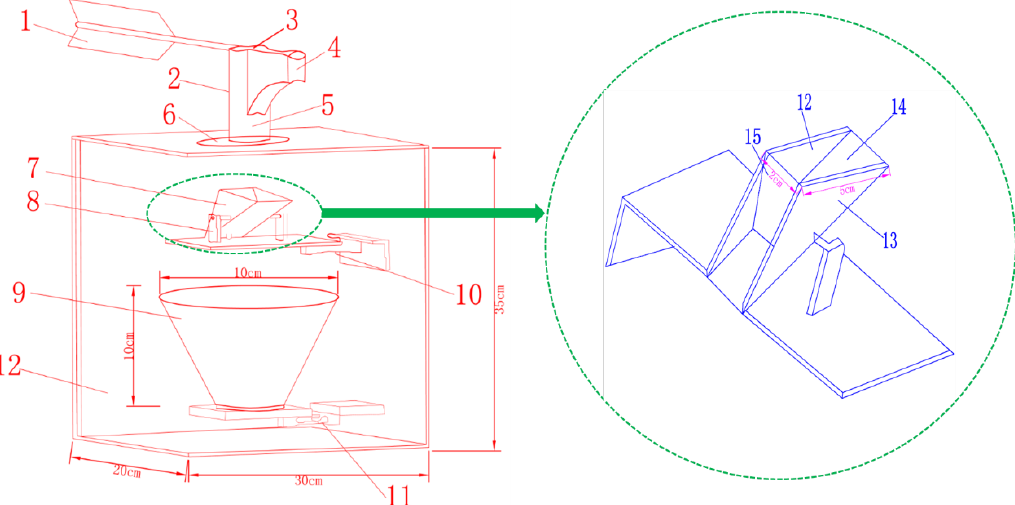
Figure 2. Structure diagram of the fully automated high-precision sand collector: 1. empennage; 2. first air leakage network; 3. second air leakage network; 4. sand intake valve; 5. hollow shaft; 6. bearing dust proof seat; 7. small-capacity container; 8. container support shaft; 9. large-capacity container; 10. small-range, high-precision weighing sensor; 11. large-scale weighing sensor; 12. first triangular plate; 13. second triangular plate; 14. first rectangular plate; 15. second rectangular plate.